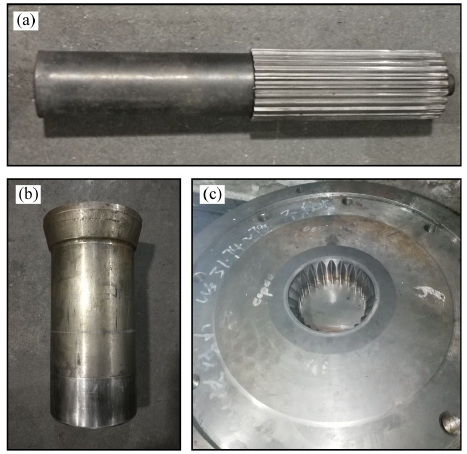
Figure 6. Experimental tools: ( a ) Mandrel; ( b ) punch; and ( c )